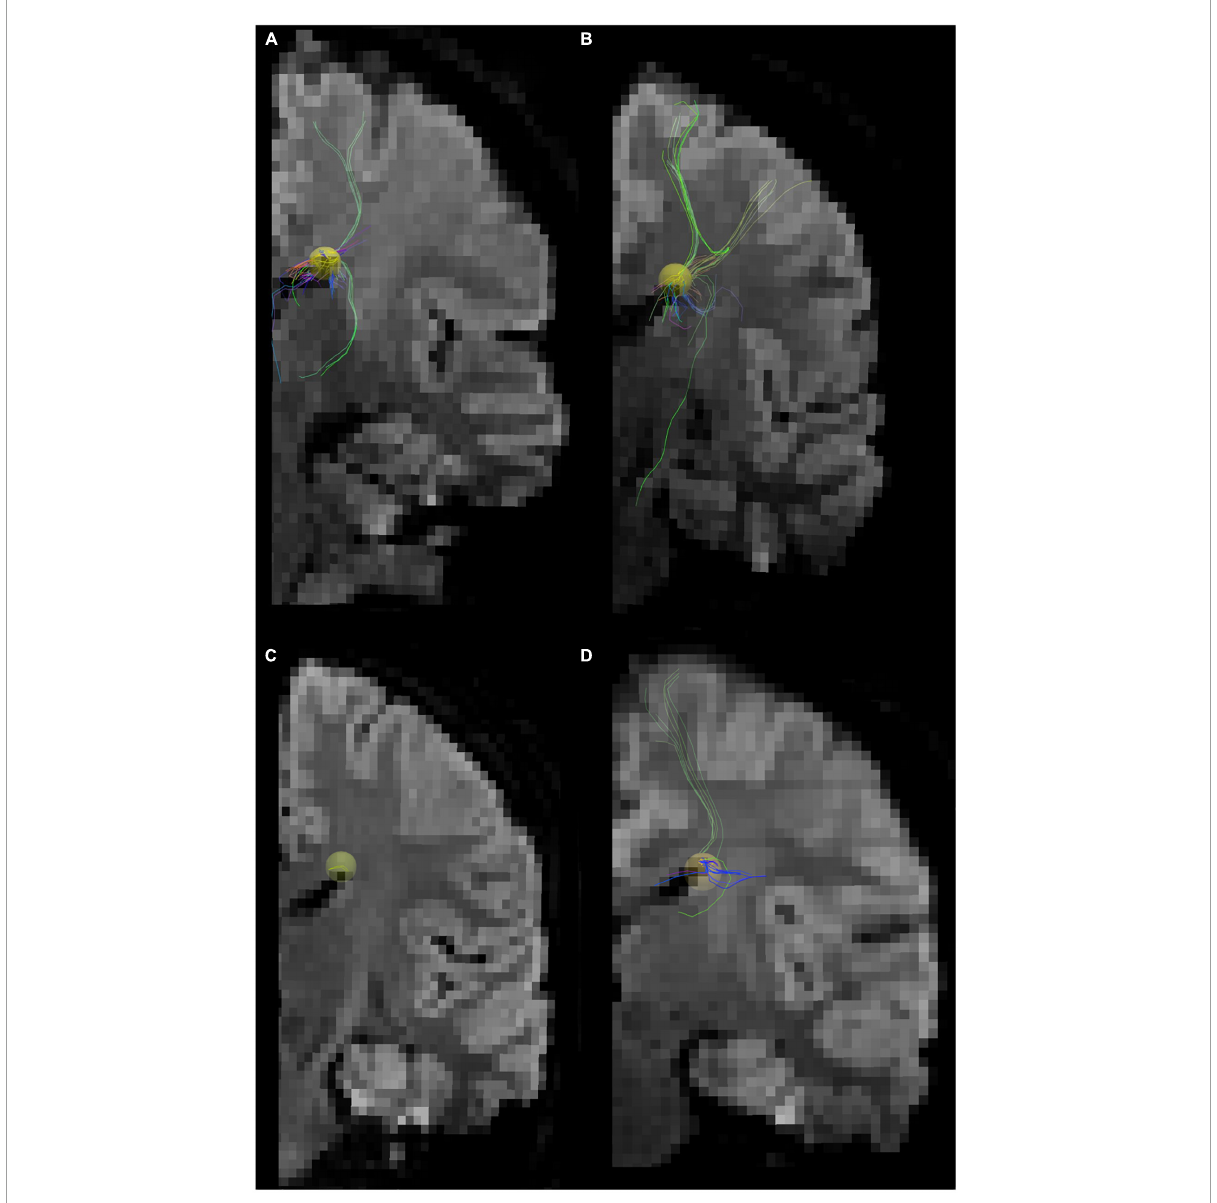
FIGURE2 Tractography pathways associated with the dorsal SVZ are more sparse and fewer in ASD compared to control in vivo . Tractography pathways associated with the dorsal SVZ in (A,B) 16YO male controls and (C,D) 16YO male patients diagnosed with ASD. We examined in vivo diffusion tractography in coronal slabs at the level of the insula and thalamus. Yellow spheres (4 mm radius) in each brain image were created in the dorsal SVZ as regions of interest (ROIs) to detect pathways from/to the